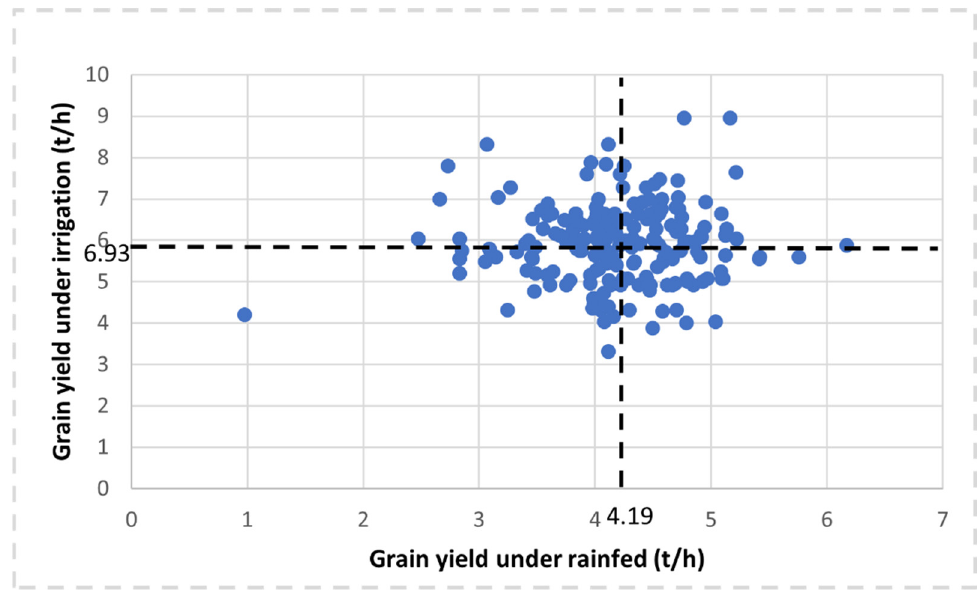
Figure 1. Scatter plots of grain yield under rainfed and irrigated conditions at Sidi El-Aidi station for 200 bread wheat genotypes grown during two seasons (2020 and 2021). Table 1. Phenotypic variation for grain yield and yield-related traits of the 200 bread wheat geno- types under rainfed and irrigated conditions.